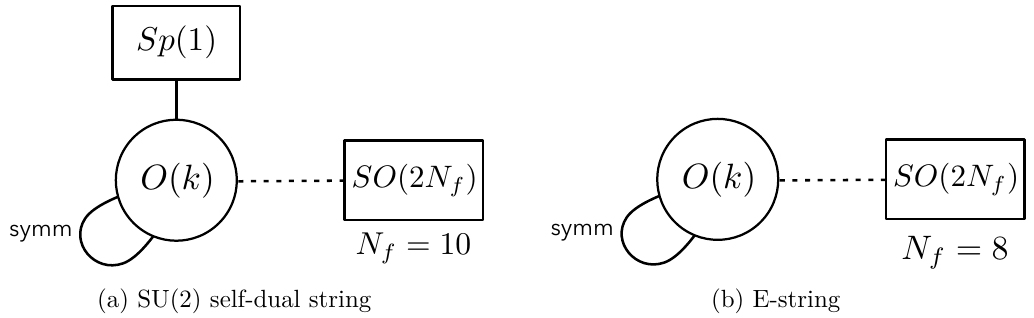
Figure 5. UV gauge theory obtained via the FI deformation of figure